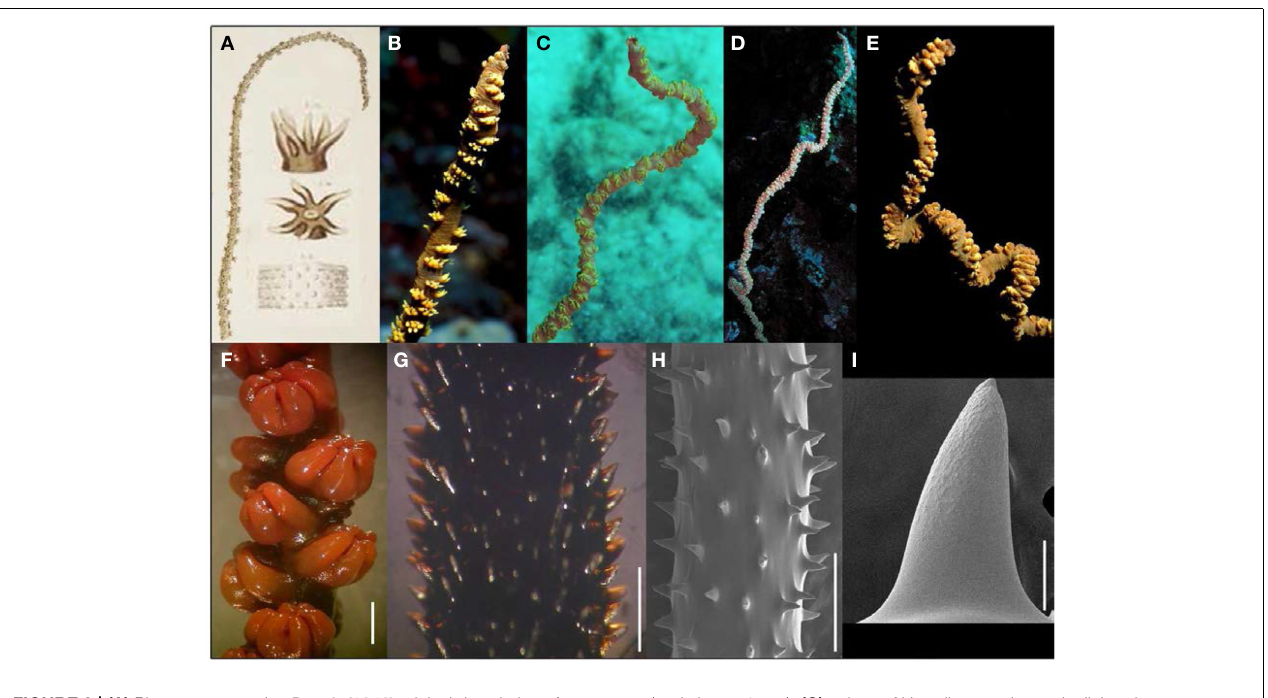
(scale bar = 1mm); (G) spines of Hawaiian species under light microscopy (scale bar = 1mm); (H,I) spines of Hawaiian species under scanning electron microscopy (scale bars: H = 1mm; I = 50 μ m). ( B–E Photos courtesy of Jim